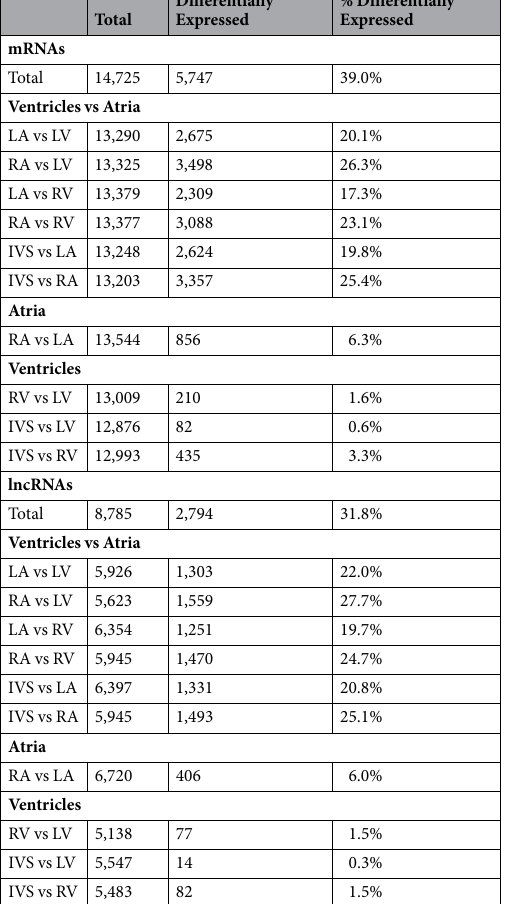
Table 1. Differential Expression of Transcripts in Non-Failing Human Hearts 1 . 1 The total number of mRNA and lncRNA transcripts that were expressed at ≥ 1 CPM in at least 6 (of 8) samples from the same region are provided. The numbers and relative percentages of transcripts with ≥ 1.5 fold difference in expression (FDR < 0.05) are also provided.